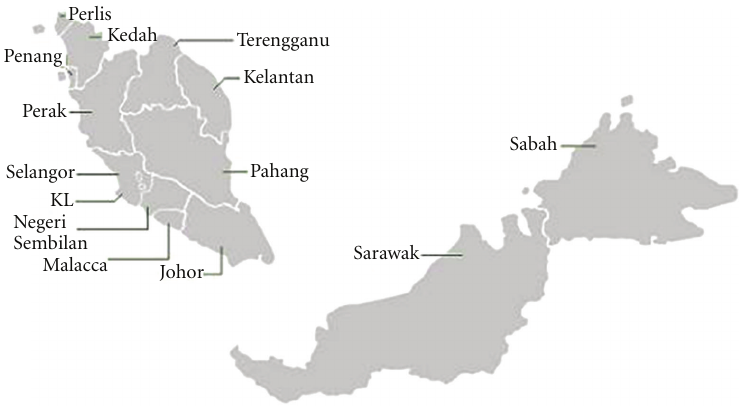
Figure 1: Malaysia political